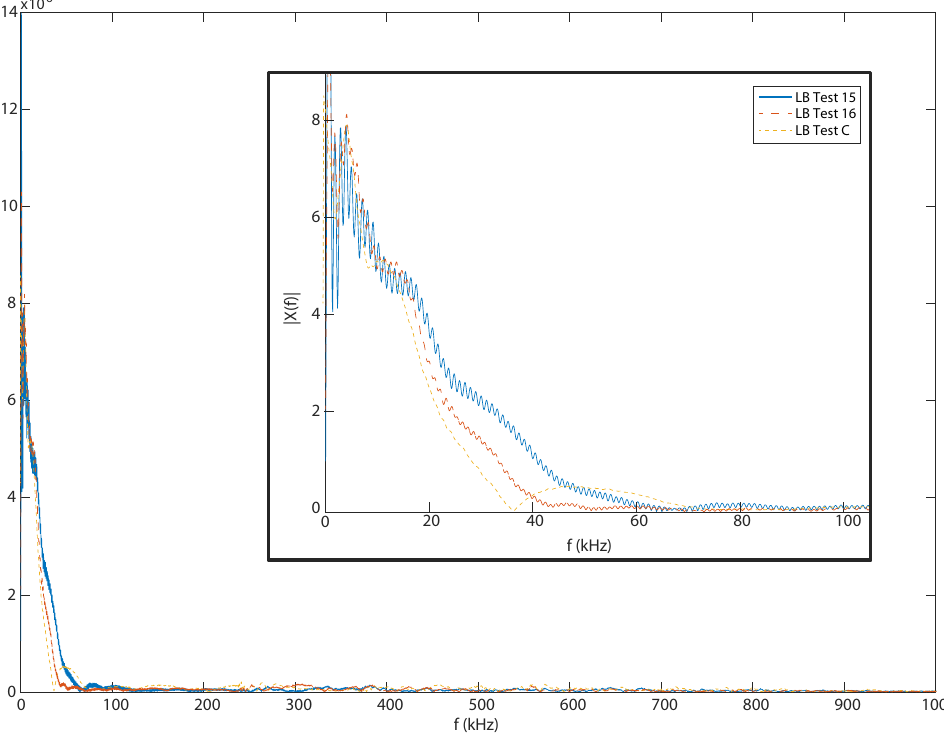
Figure 6. FFT analysis of LB experimental pressure signals. Numerical test IDs are consistent with [30], with alphabetical being previously unpublished. Figure inset is a zoomed in section of the same